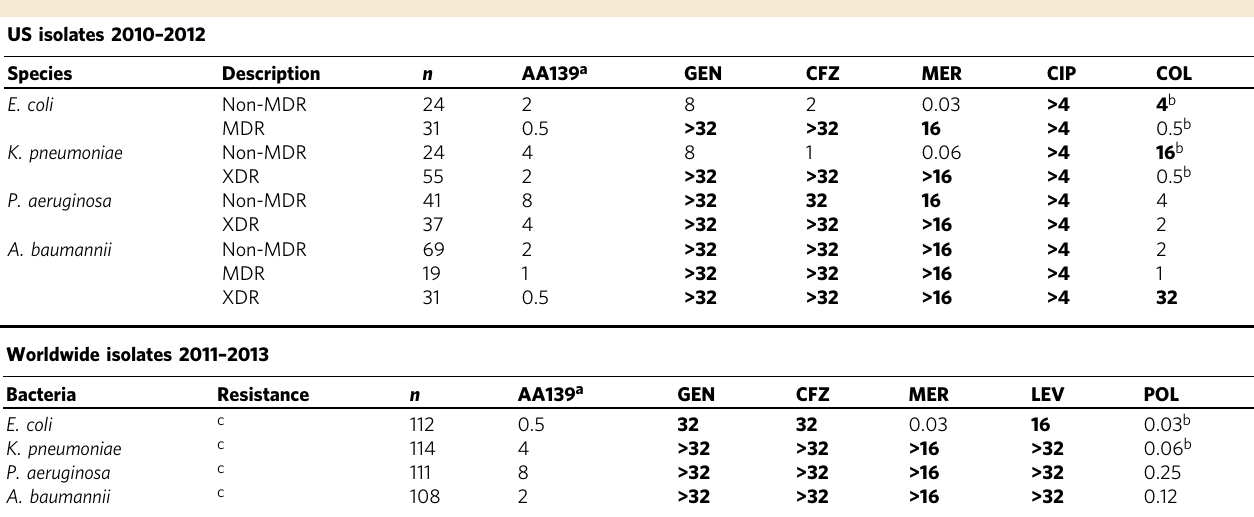
Table 3 AA139 assessed for antimicrobial activity against two clinical isolate panels. US isolates 2010 – 2012